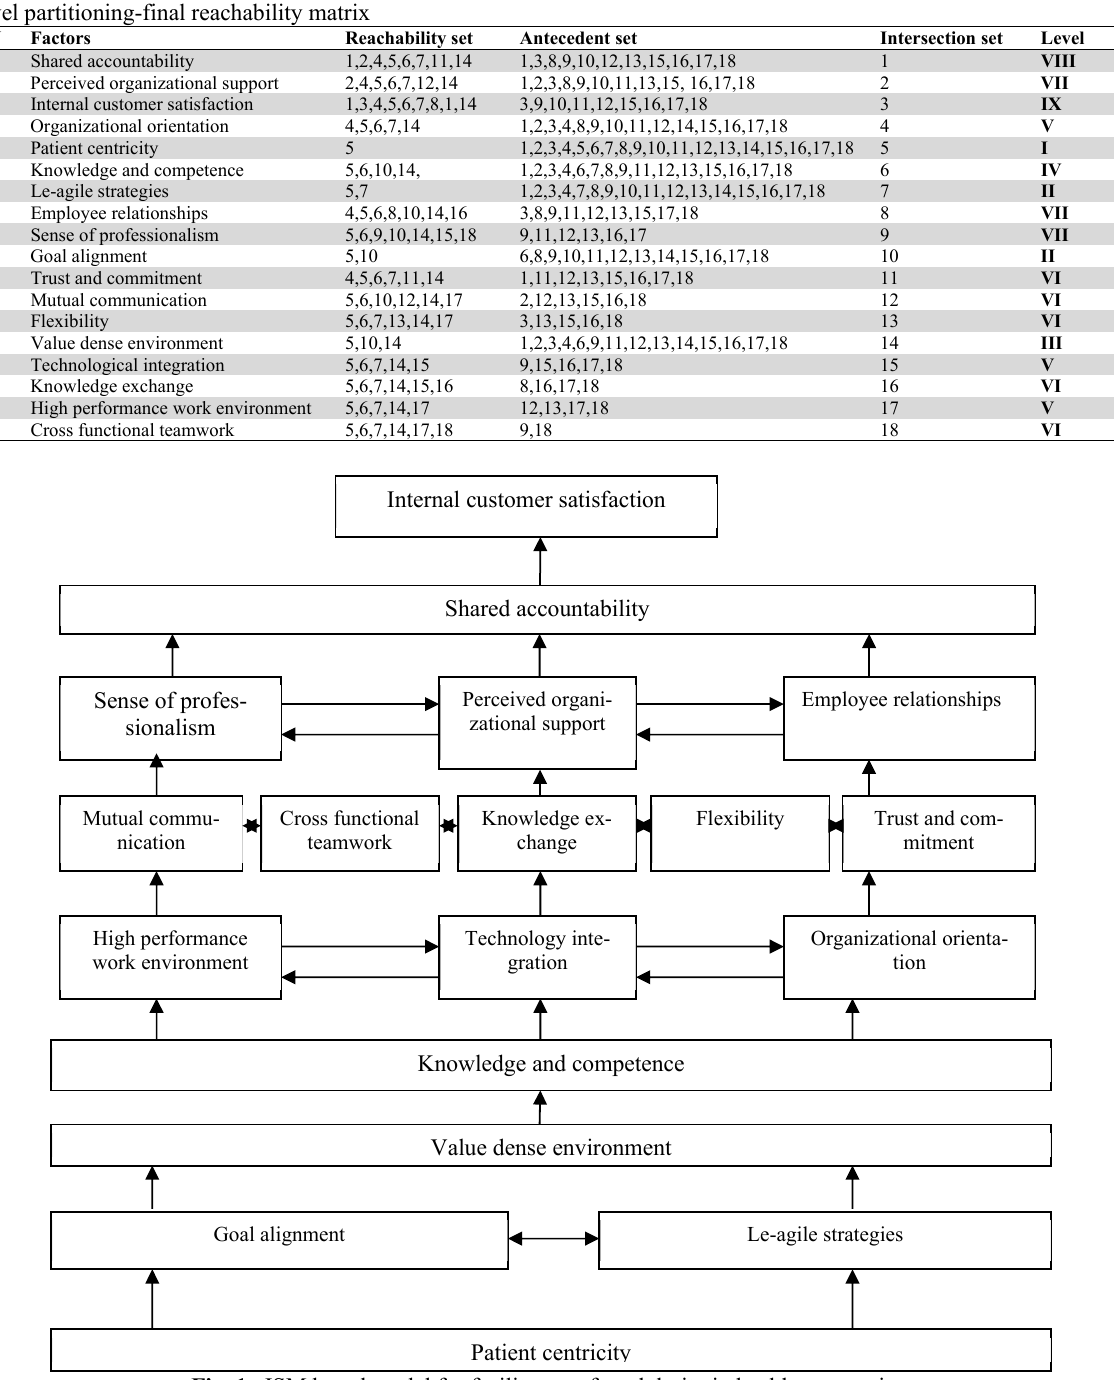
Fig. 1. ISM based model for facilitators of modularity in healthcare